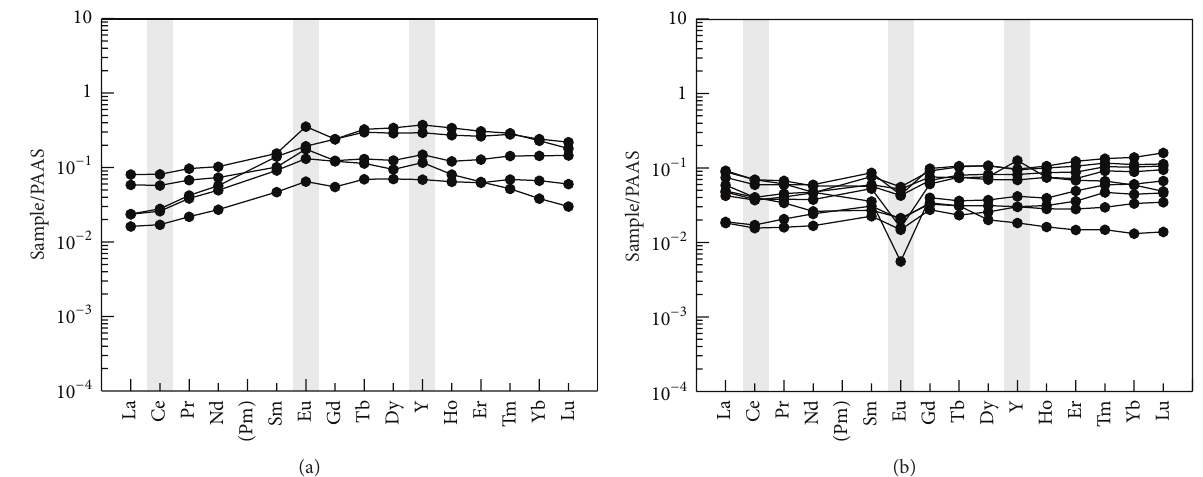
Figure 14: PAAS normalized REE pattern for siliceous rocks from the Bafangshan-Erlihe area.